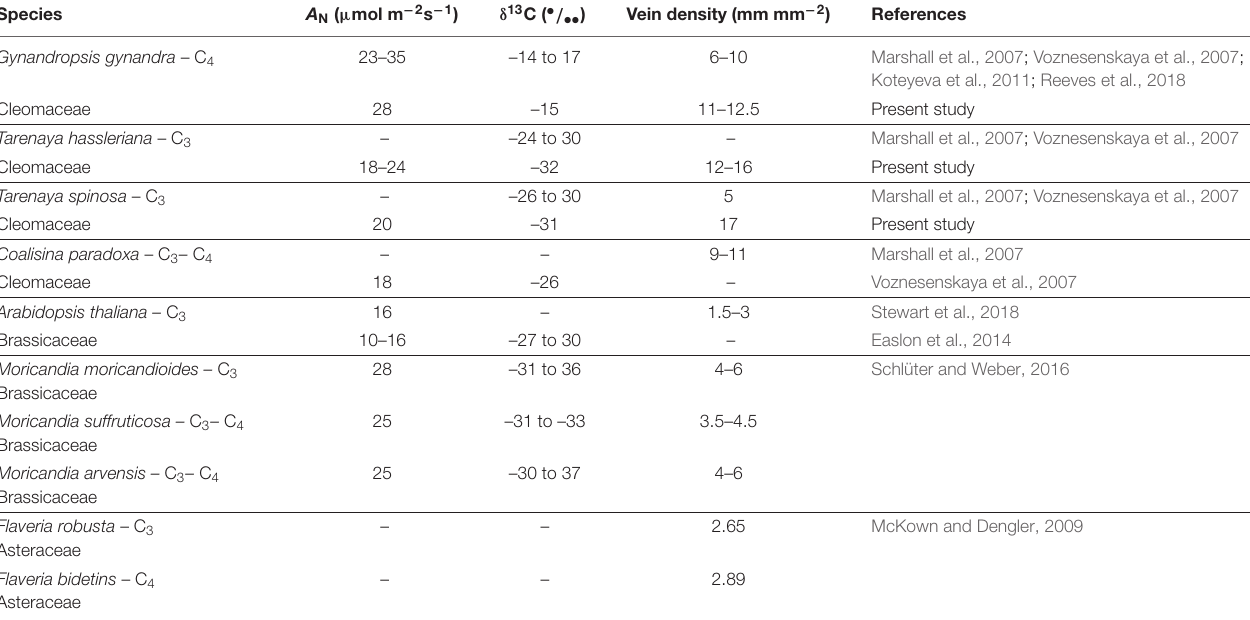
TABLE 2 | Physiological variation for photosynthetic gas-exchange and anatomical parameters among diverse species of Cleomaceae, Brassicaceae, and Asteraceae.